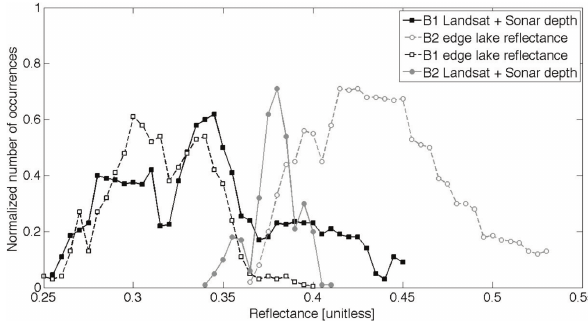
Fig. 5. Distribution of Ad values for the Landsat bands 1 and 2 estimated from Eq. (2) using lake depth measured by the boat (cont. lines) and of reflectance values from the edge lake (dashed